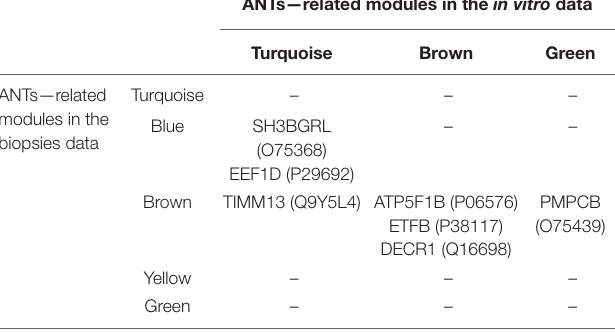
TABLE 3 | The high module membership proteins in both in vitro and human biopsies datasets. ANTs—related modules in the in vitro data Turquoise Brown